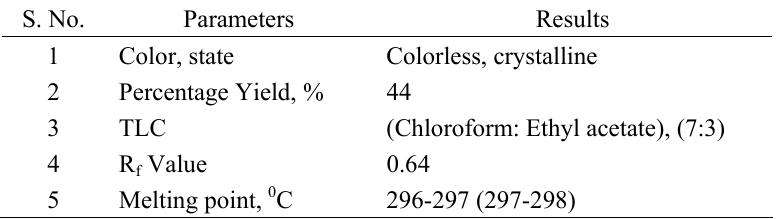
Table 1. Physical data of